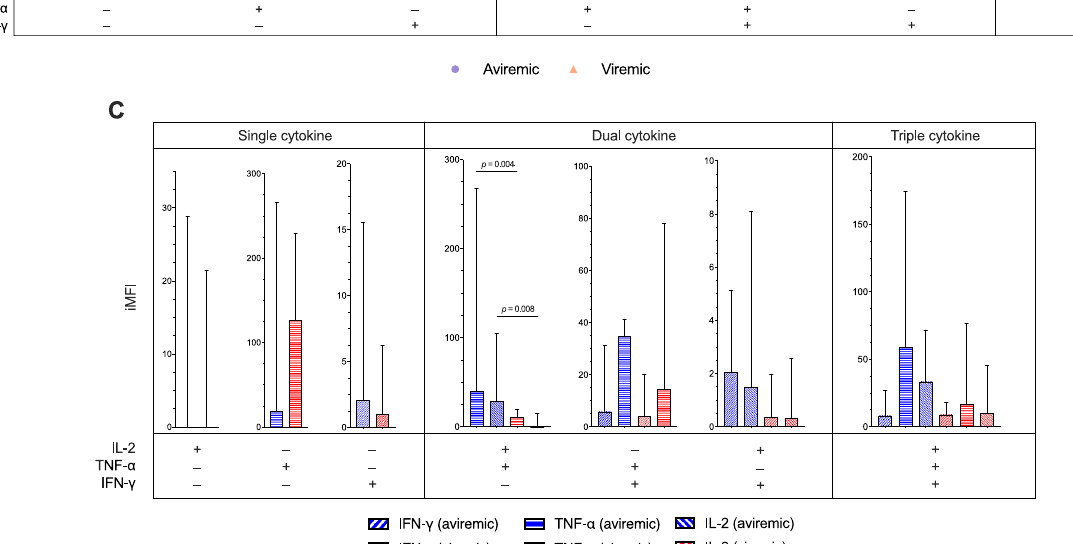
Study population. We consecutively enrolled patients with ascertained acute COVID-19 (positive RT-PCR